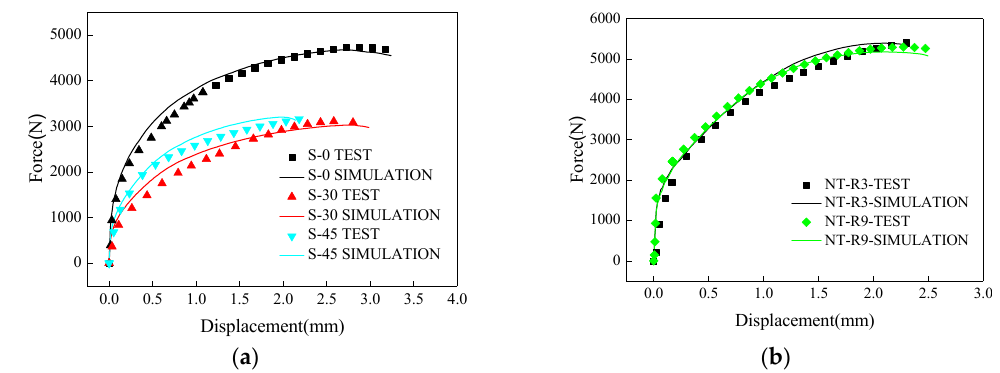
Figure 4. Comparison of experimental and simulated force-displacement curves. ( a ) Shear-dominated specimens; ( b ) notched specimens.